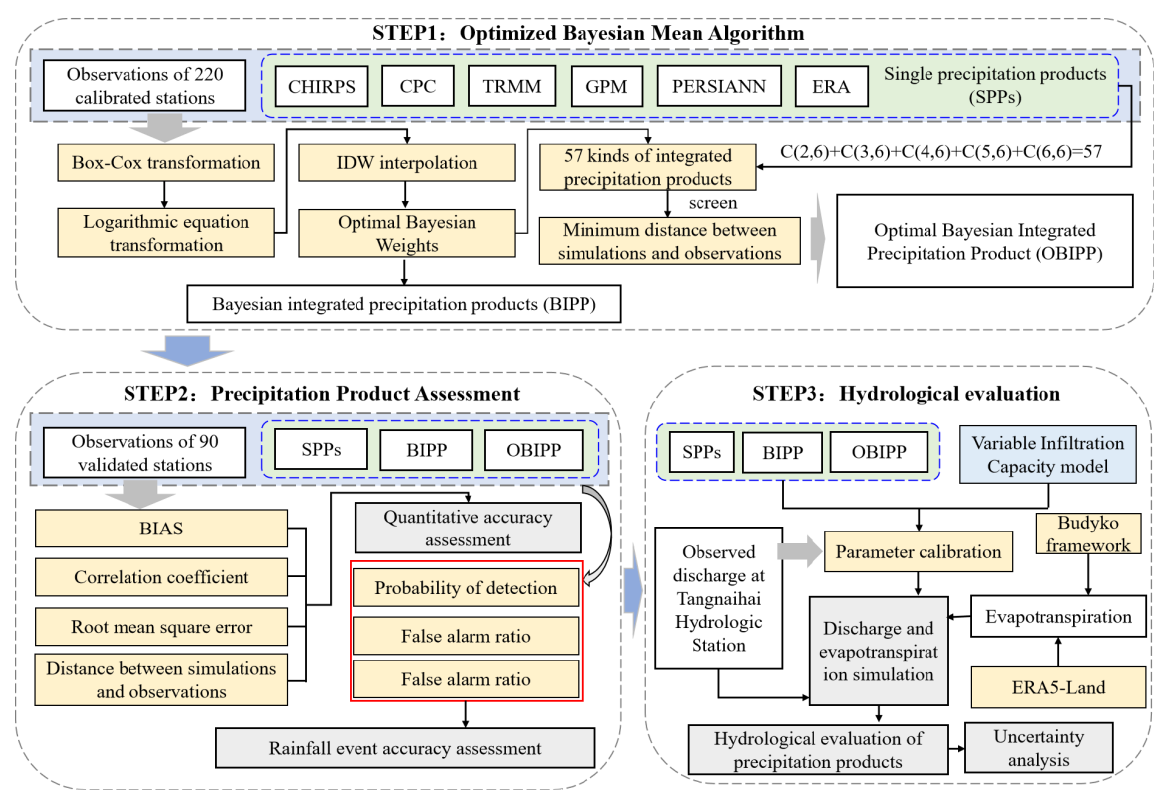
Figure 3. The methodological framework of this study.